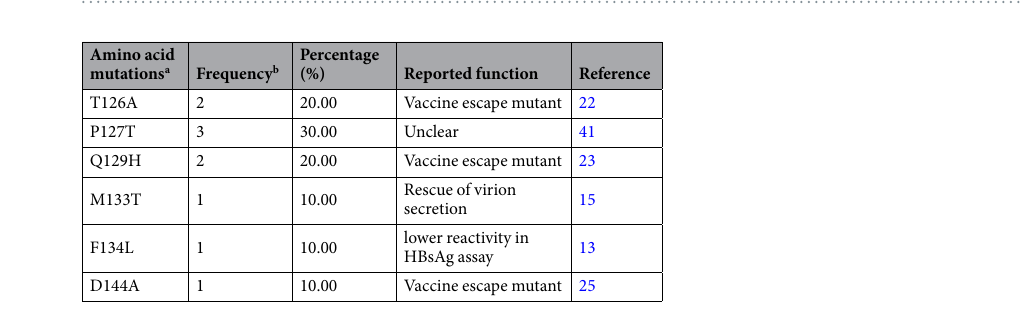
Table 4. Amino acid mutations in the “ α ” determinant of HBsAg from genotype B among HBV-infected children. a Amino acid aa mutants were presented based on their location in the archived GenBank reference FJ562246. b Frequency reflected the number of cases in which the mutations was